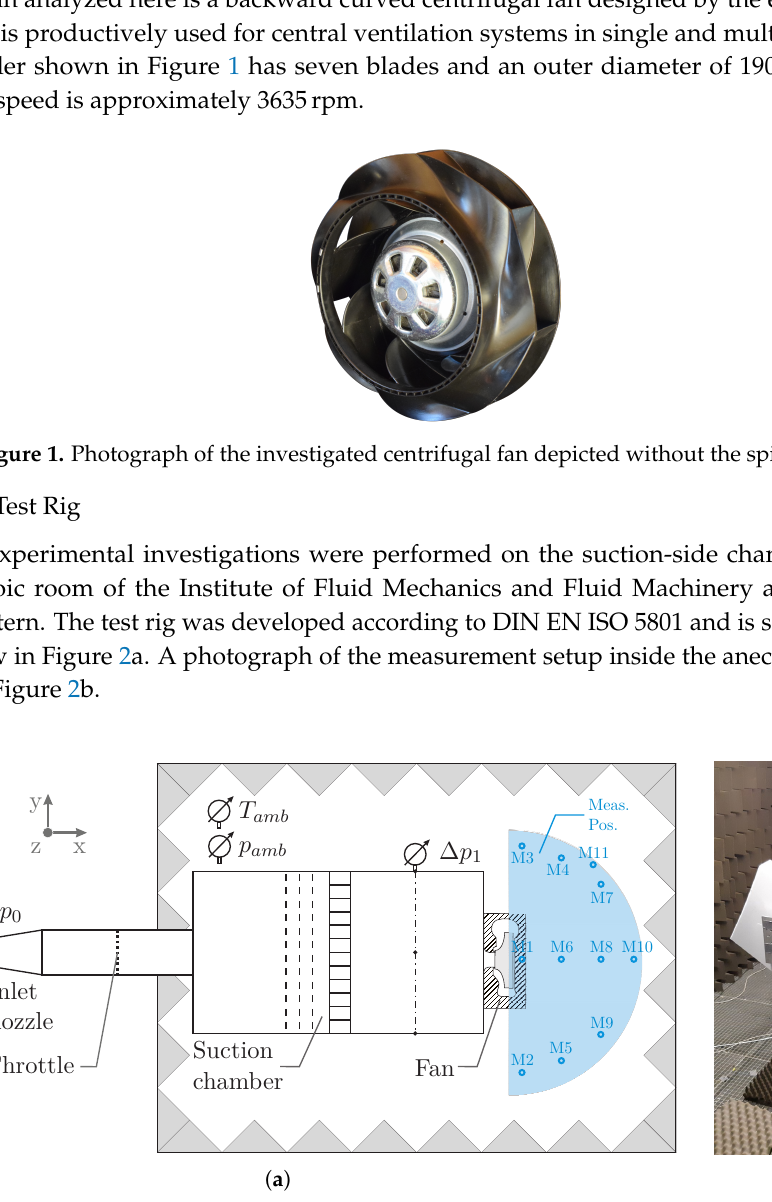
Figure 2. Schematic view of the fan test rig as top view ( a ) and photograph of the measurement setup inside the anechoic room facility ( b